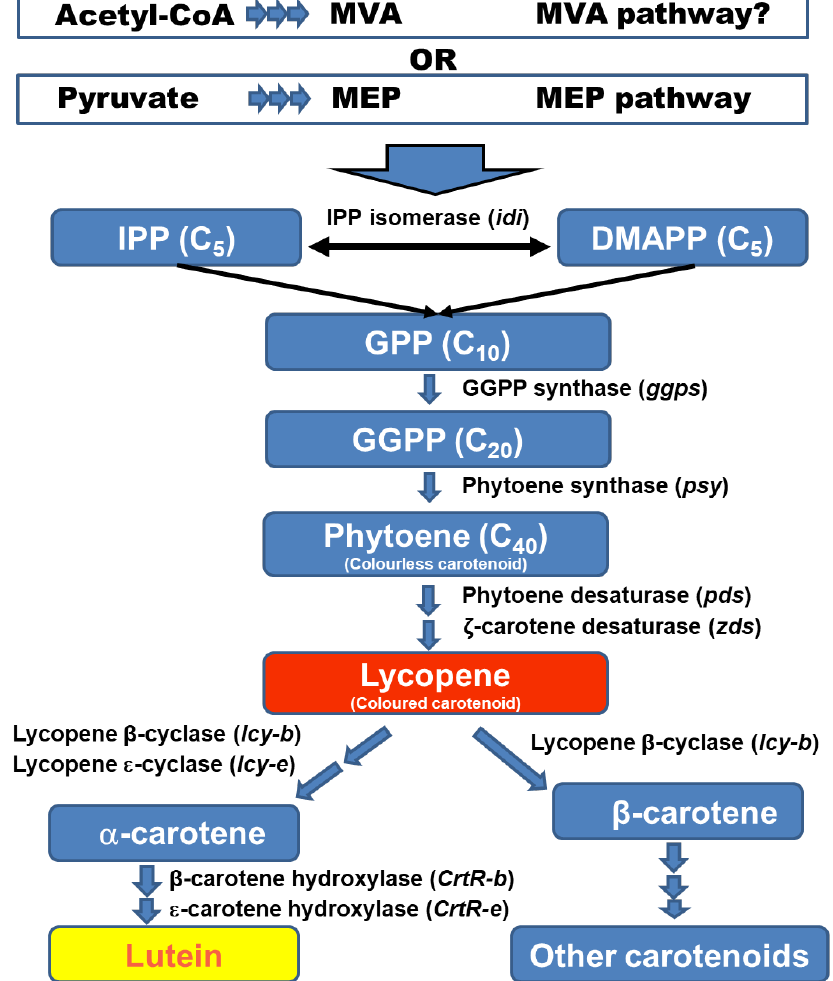
Figure 2. Schematic overview of lutein biosynthesis in microalgae. Enzymes involved in each biochemical conversion step are listed and their corresponding genes are indicated in parenthesis.